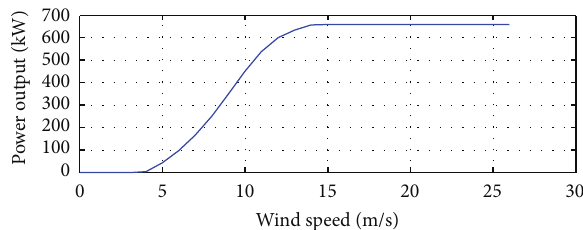
Figure 5: Typical wind turbine power curve.